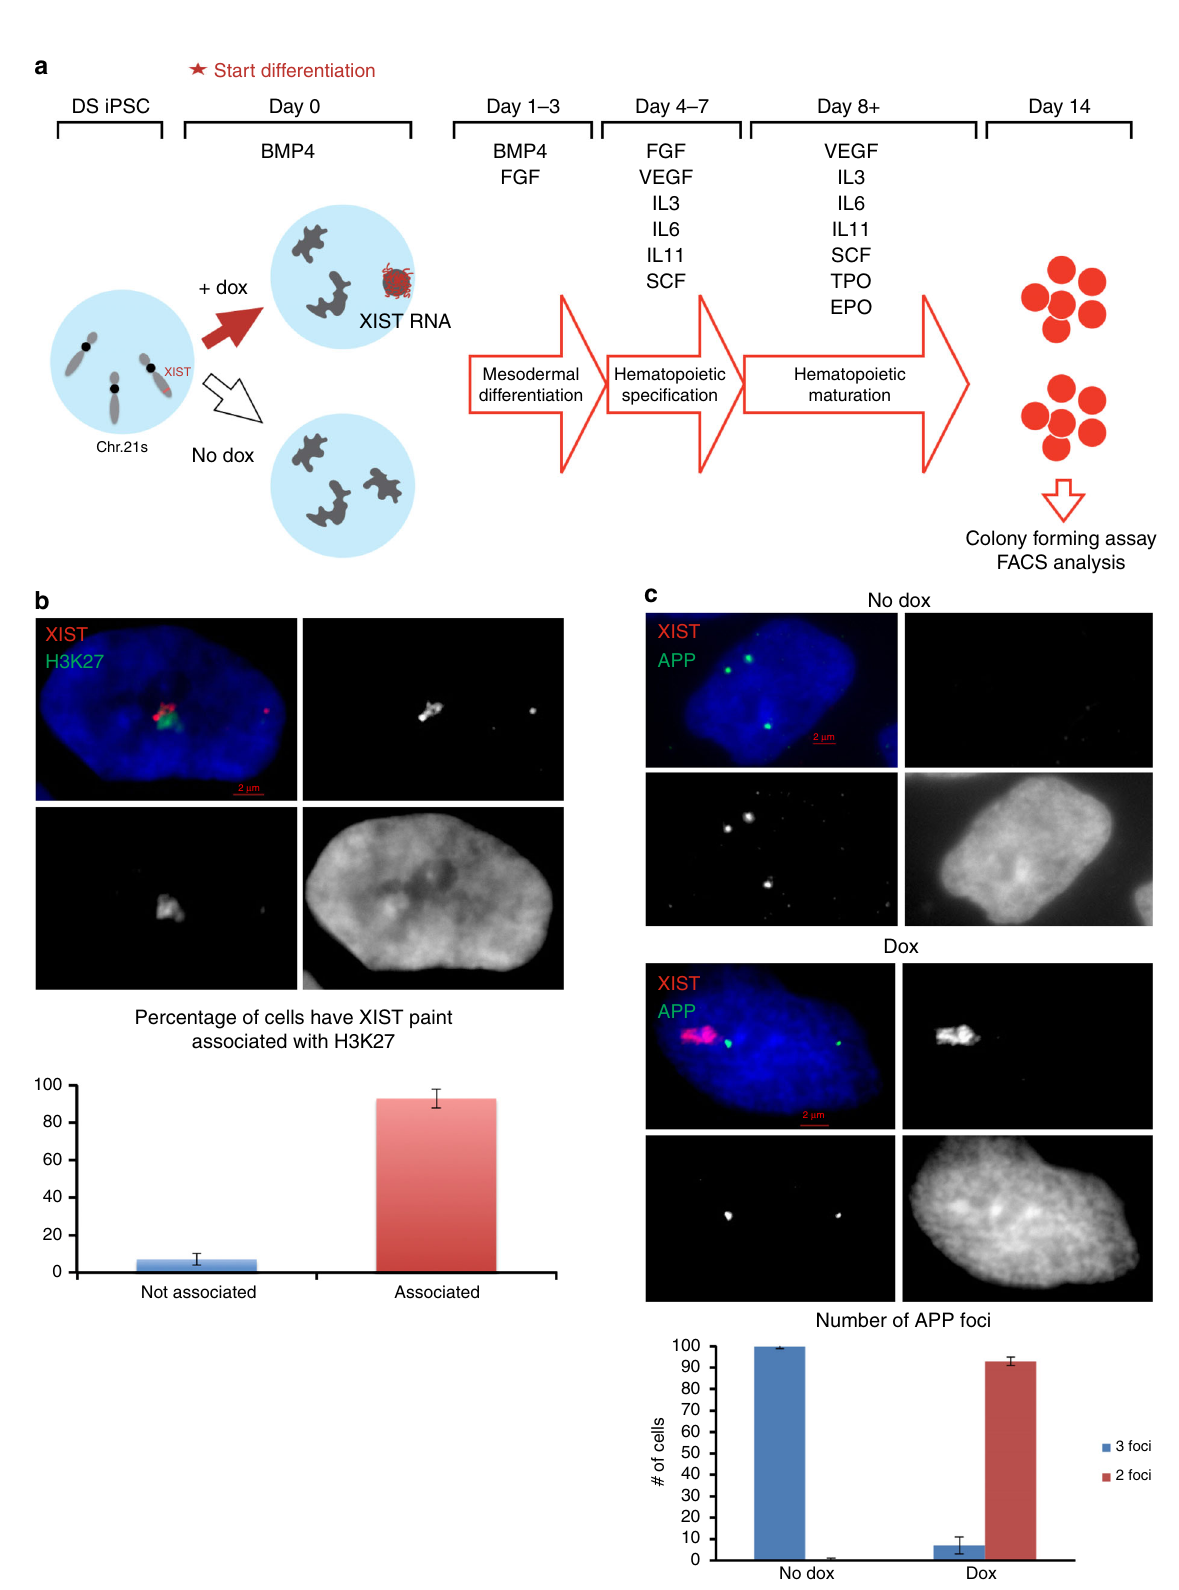
Fig. 2 Trisomy silencing during hematopoietic differentiation. a Schematic of hematopoietic differentiation from DS iPSCs. b Association of H3K27me3 heterochromatic mark with XIST RNA in day 9 puri fi ed CD34 + differentiated cells treated with dox. Quanti fi cation shows over 90% of cells have H3K27me3 marker associated with XIST paints. c RNA FISH of APP and XIST on day 9 differentiating cells. APP RNA transcription foci from all three alleles in untreated cells (top). In treated cells (bottom), only two APP transcription foci are detected, indicating transcriptional silencing induced by XIST expression. Quanti fi cation shows over 90% of XIST expressing CD34 + cells have only two APP transcription foci (which are not from XIST expressing chromosome). Error bars for b and c represent s.e.m. from three independent